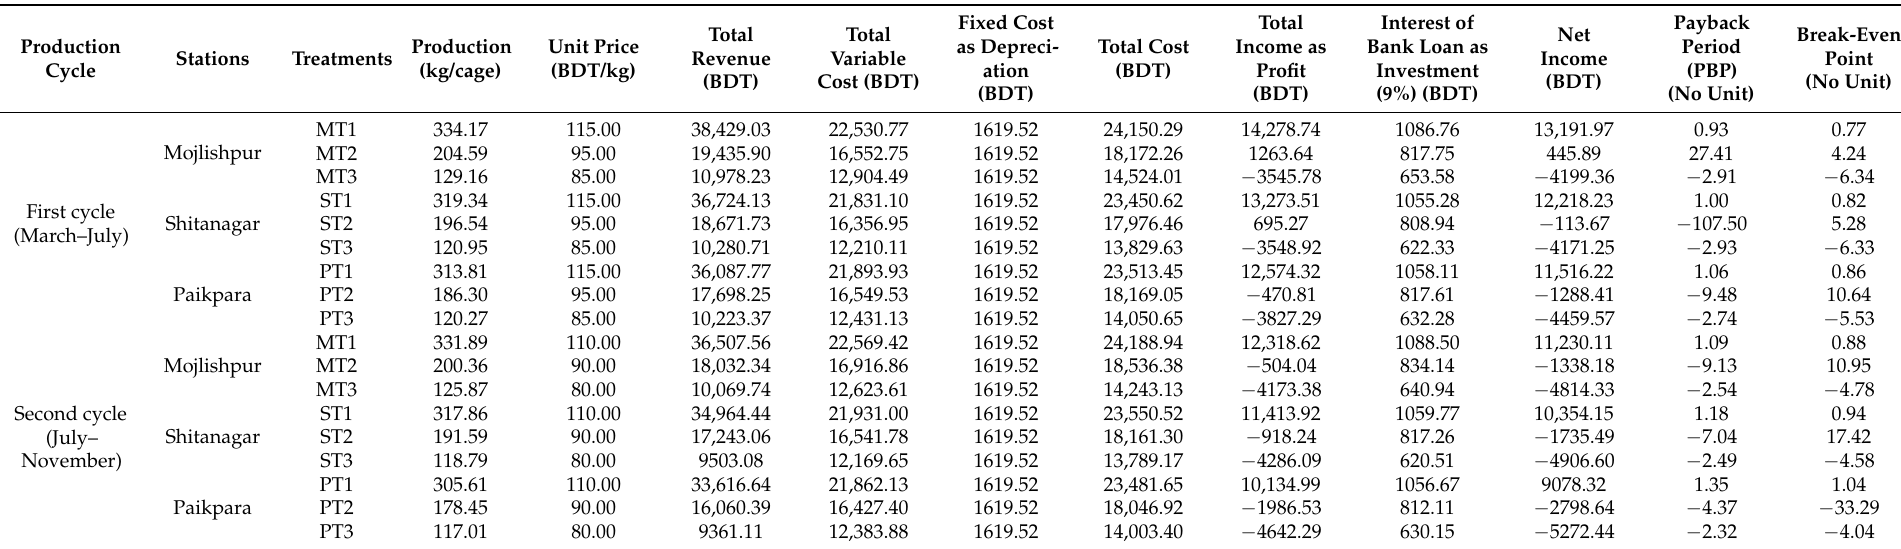
Table 7. Revenue return (BDT) and economic feasibility of Nile Tilapia ( O. niloticus L.) culture for 120 days under cage-culture